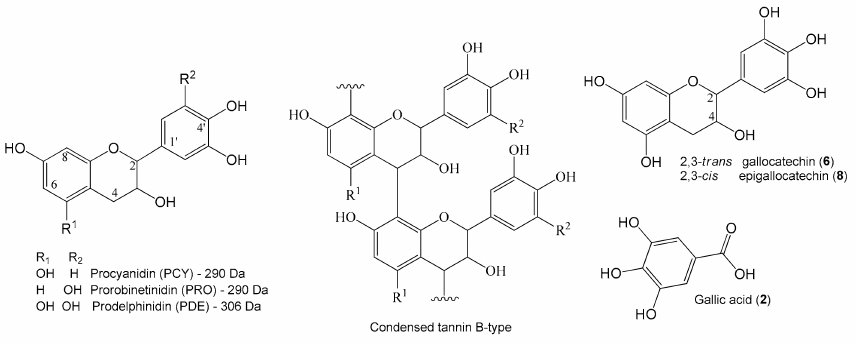
Figure 2. Structures of flavan-3-ol monomers composed the proanthocyanidins from S. adstringens aqueous extract (SAAE), a typical condensed tannin B-type and some chemical compounds that were